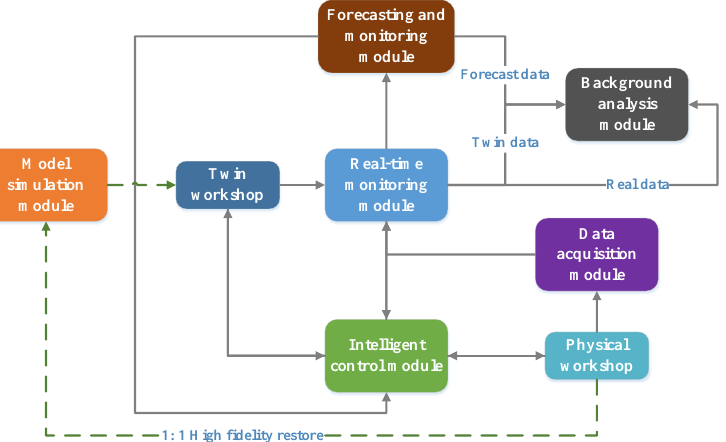
Figure 2. F unctional logic of the workshop digital twin system . Figure 2. Functional logic of the workshop digital twin